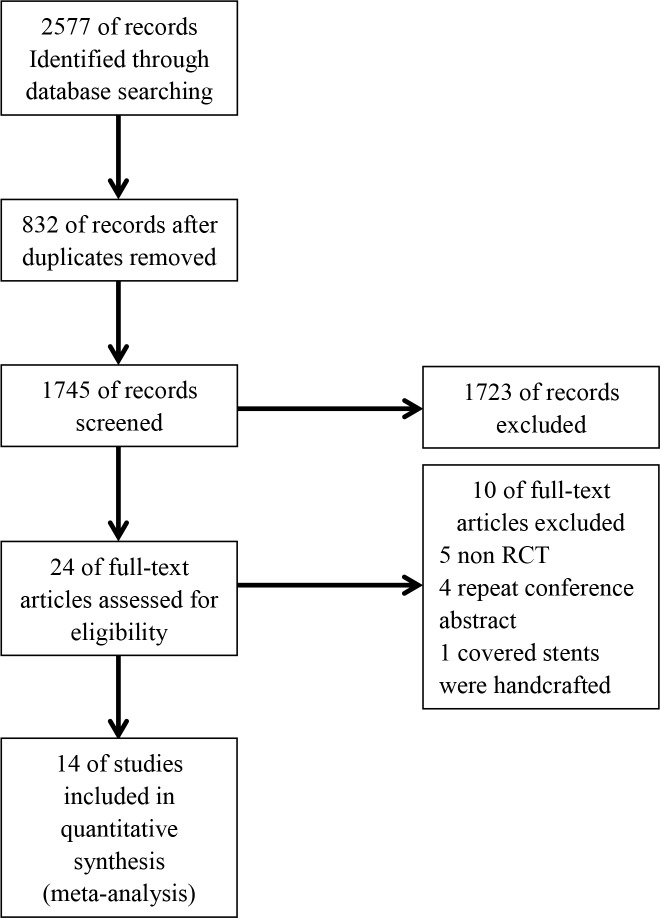
Study flow diagram.